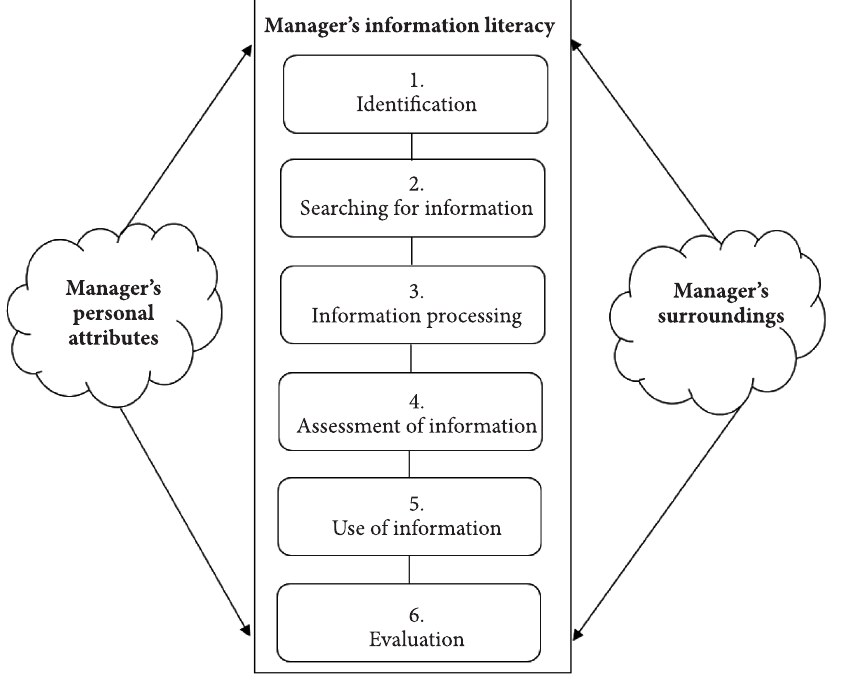
Figure 3. The Model of Manager Information Literacy (source: own